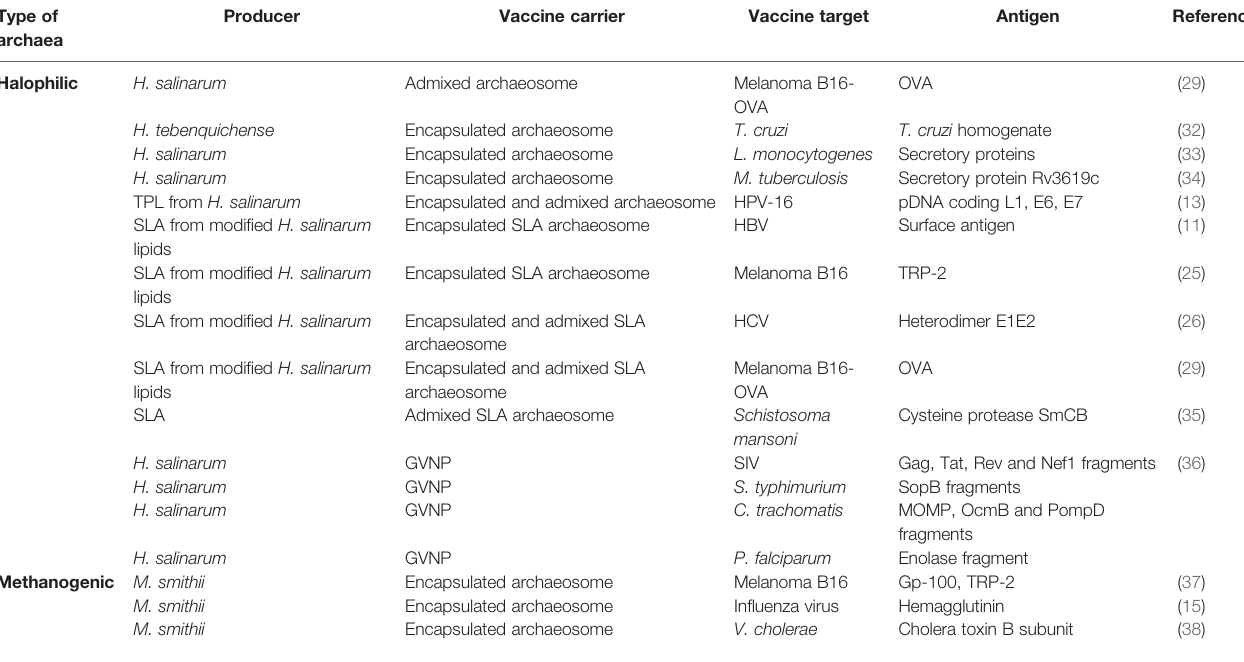
TABLE 1 | Archaeal